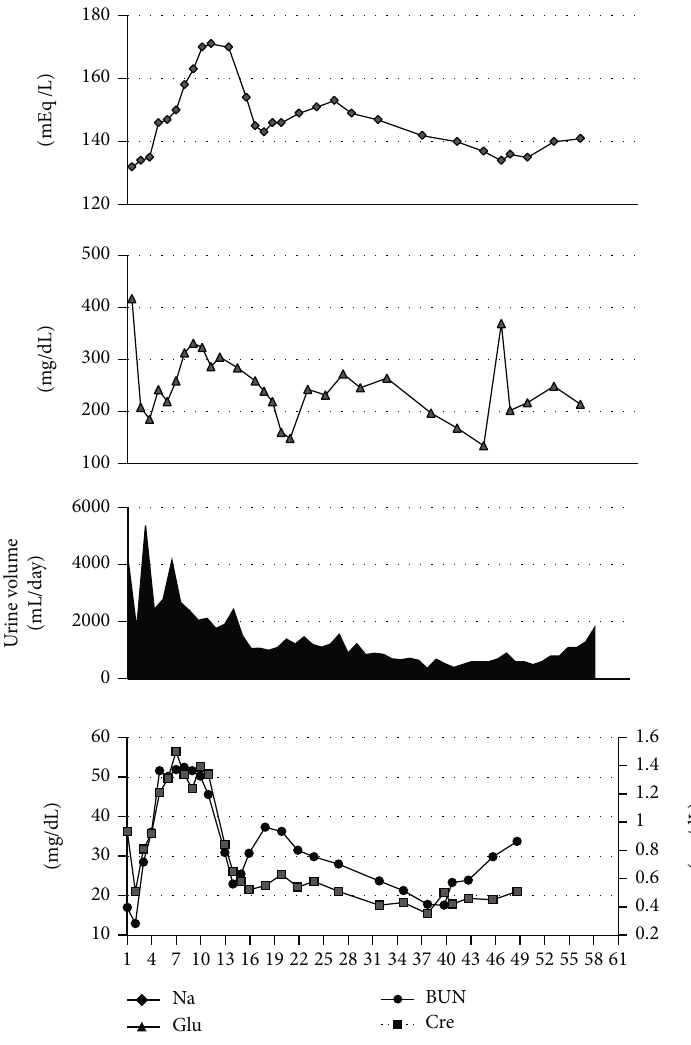
Figure 6: Clinical course of the patient concerning the levels of sodium, blood glucose, urine volume, BUN, and Cre. BUN: blood urea nitrogen; Cre: